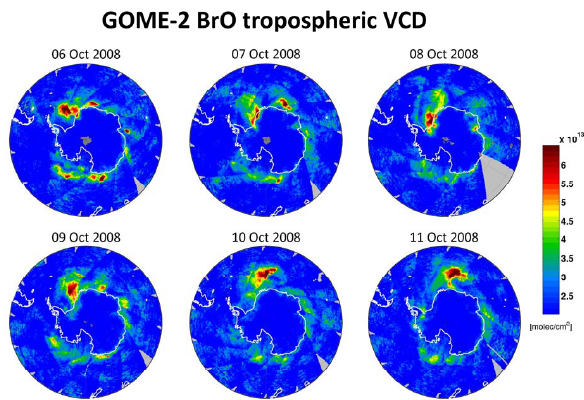
Fig. 6. Tropospheric vertical column density BrO derived from the Figure 6. Tropospheric vertical column density BrO derived from the GOME ‐ 2 instrument during the 596 GOME-2 instrument during the October ozone depletion October ozone depletion event. 597